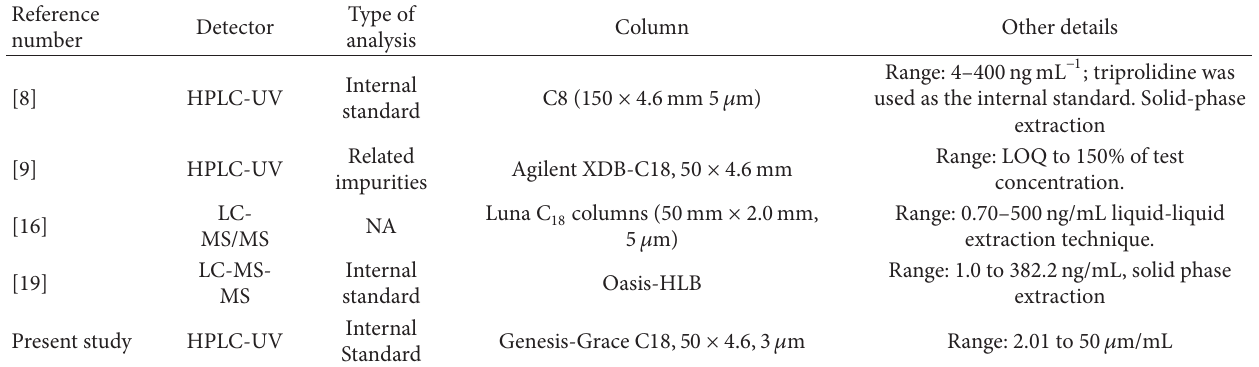
T 11: Comparison study of various methods with present analytical